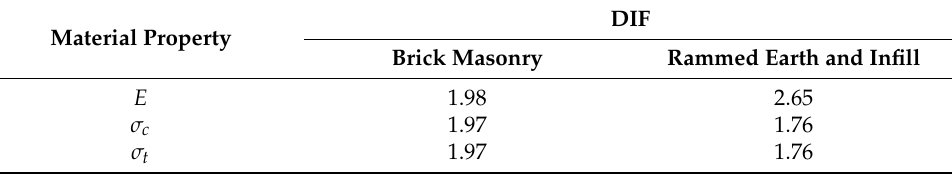
Table 1. Dynamic increase factors for the brick masonry, the rammed earth, and the infill under blast